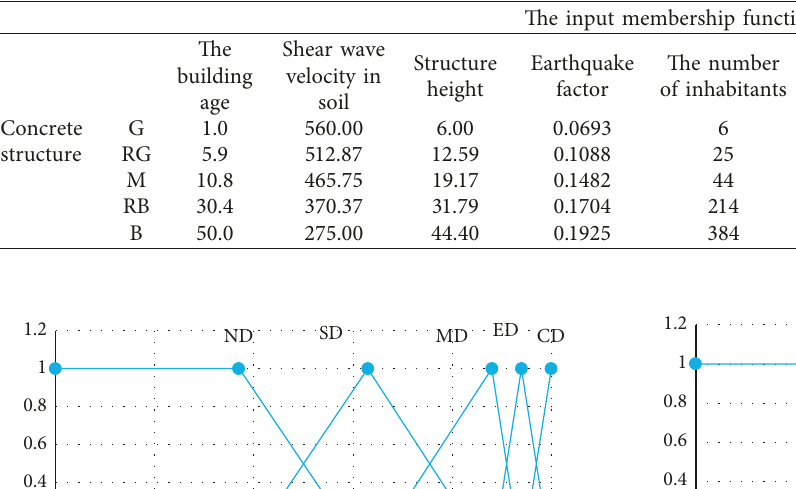
Table 3: The input membership function range of concrete structures.